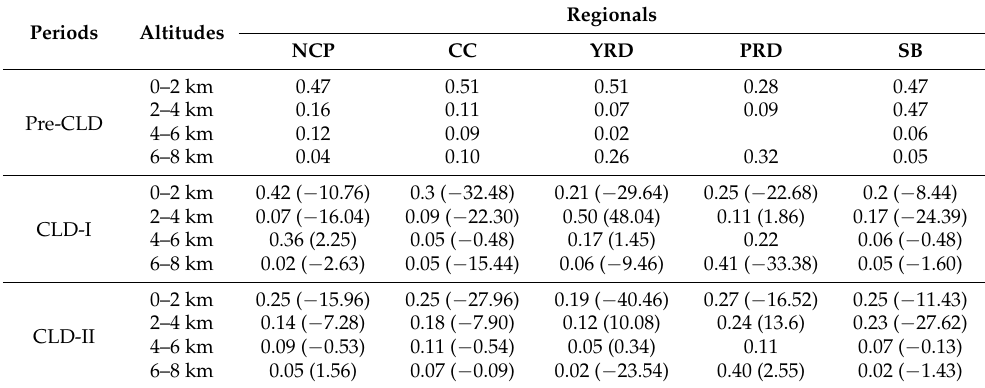
Table 3. Statistics of AEC of different layers.